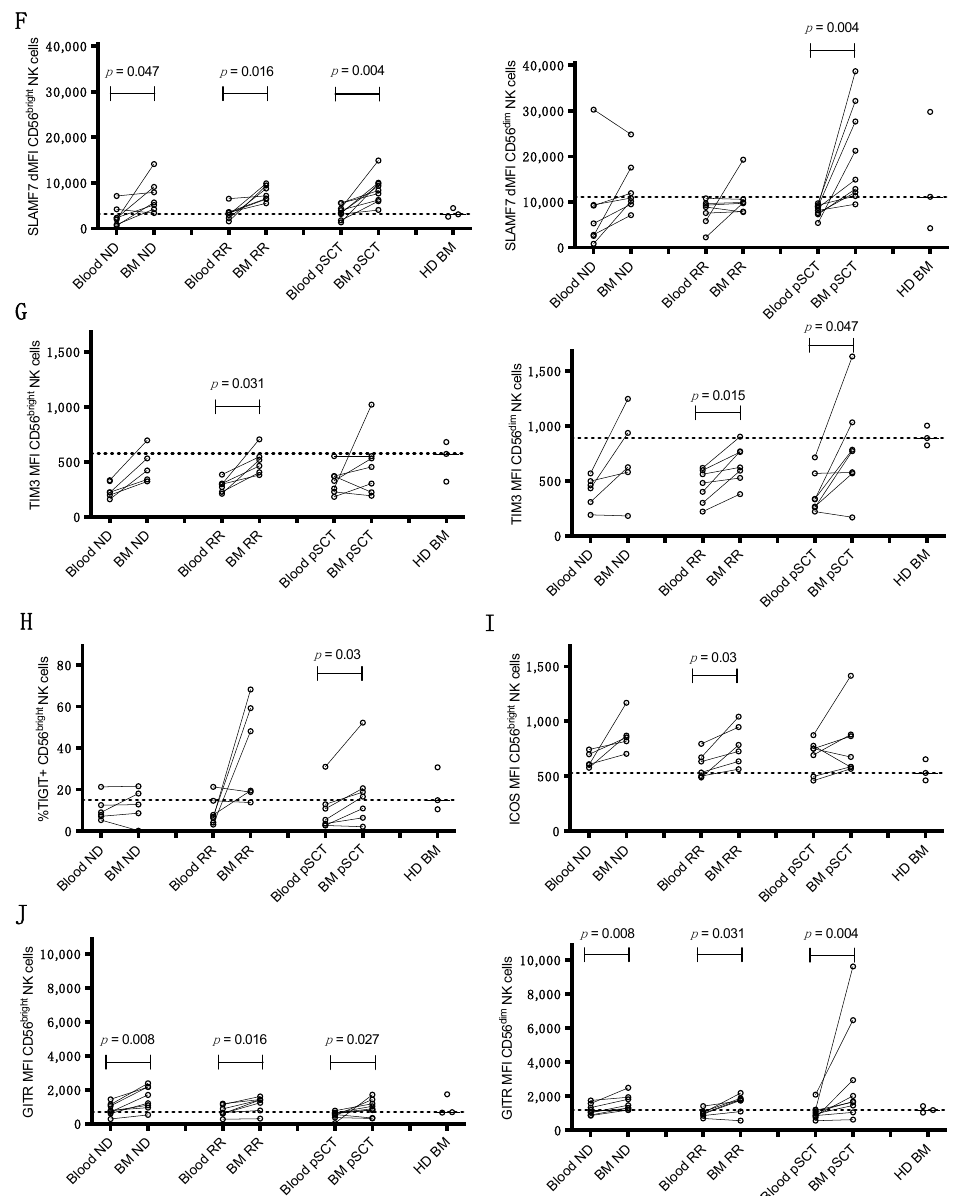
Figure 2. Comparisons of expression levels of various surface markers on NK cells in the blood versus bone marrow (BM) of patients in different MM disease subgroups. Values in blood and BM from each patient are connected by solid black lines. ( A ) Comparisons of % of total viable lymphocytes that are CD45 + CD3 − CD56 + NK cells in blood vs. BM. Comparison of various NK cell receptors and markers on blood vs. BM: ( B ) % CD56 dim NK cells that are CD57 + , ( C ) % CD56 bright (left) and CD56 dim NK cells that are CD69 + (right), ( D ) % CD56 bright (left) and CD56 dim NK cells that express DNAM-1 (right), ( E ) NKG2D expression level (NKG2D dMFI) on CD56 bright (left) and CD56 dim NK cells (right), ( F ) SLAMF7 expression level (SLAMF7 dMFI) on CD56 bright (left) and CD56 dim NK cells (right), ( G ) TIM3 expression level (TIM3 MFI) on CD56 bright (left) and CD56 dim NK cells (right), ( H ) % CD56 bright NK cells that are TIGIT + , ( I ) ICOS expression level (ICOS MFI) on CD56 bright NK cells, ( J ) GITR expression level (GITR MFI) on CD56 bright (left) and CD56 dim NK cells (right). Dashed lines in each panel designate the median expression of each receptor on NK cells from BM of the three HDs (right), demonstrating significant shifts in expression levels in the BM of many MM patients. p values comparing blood to BM were calculated using Wilcoxon paired signed-rank tests.